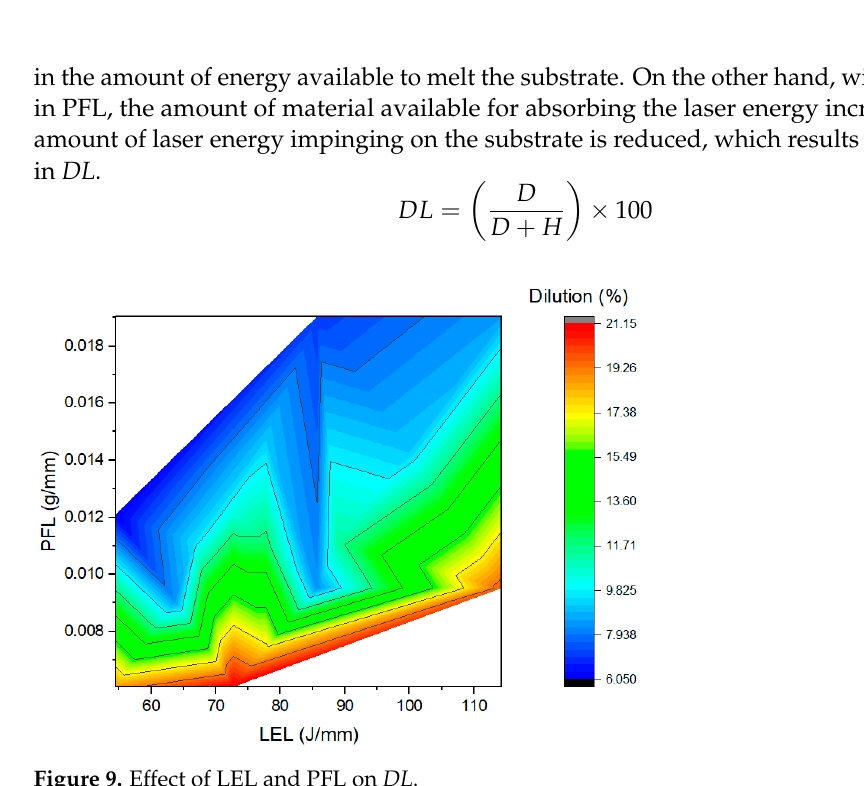
Figure 9. Effect of LEL and PFL on DL .